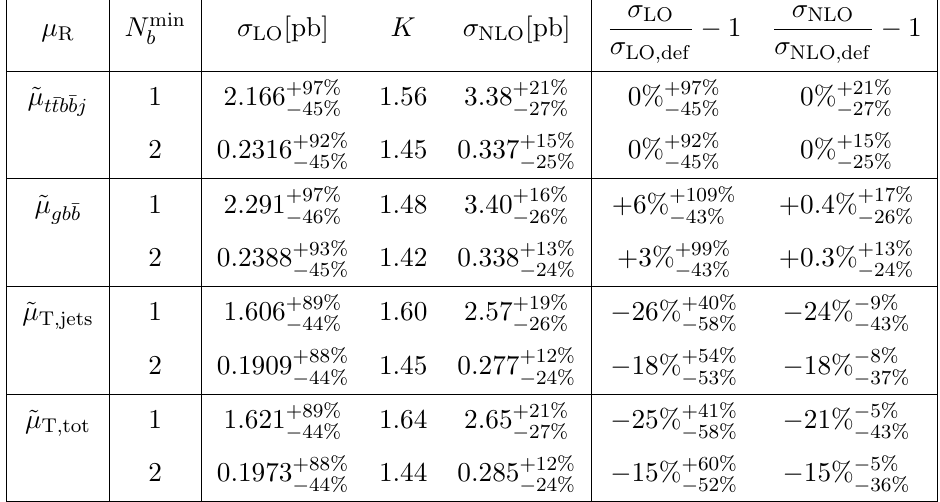
t (cid:22) tb (cid:22) bj at p s = 13 TeV in the ttbj ( N min !